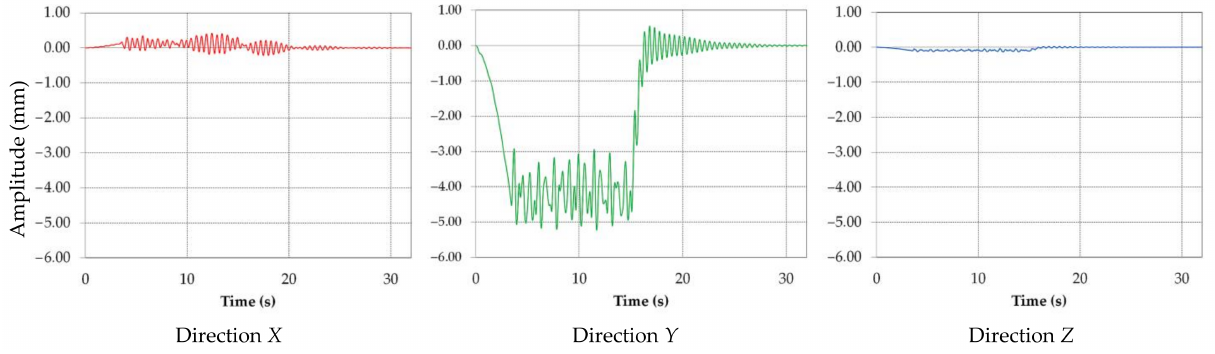
Figure 22. Displacement for direction X , Y and Z resulting from the time response analysis.